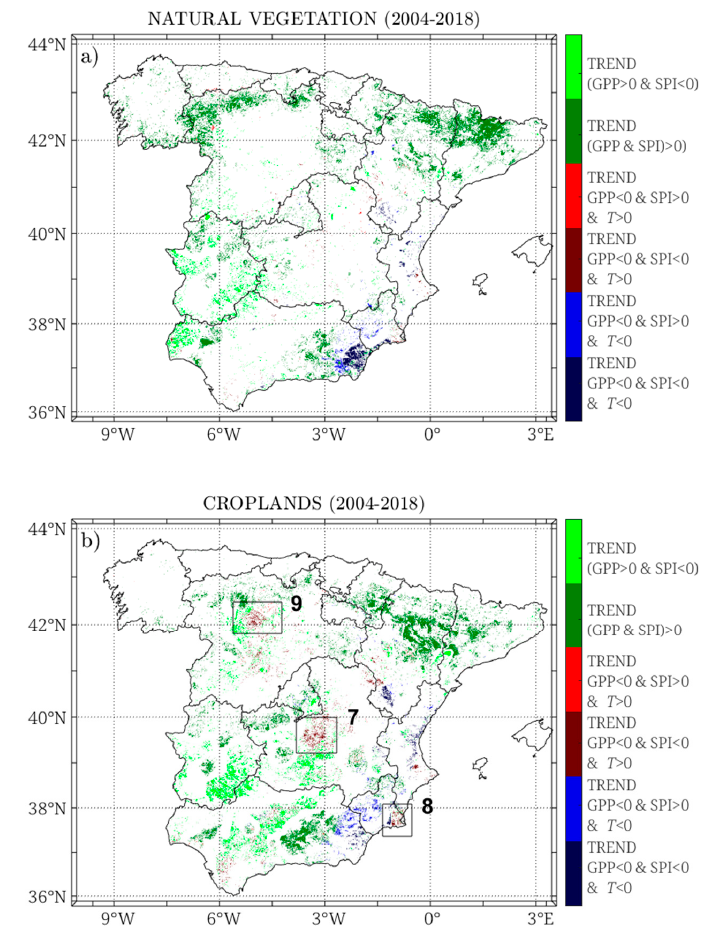
Figure 6. SPI slope ( Q SPI ; p -value < 0.3) ( a ) and temperature slope ( Q T ; p -value < 0.1 ( b ) derived from daily spatialized meteorological station values.